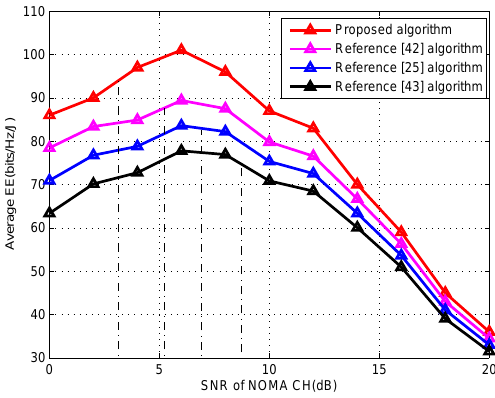
Figure 11. Comparison of average EE under different